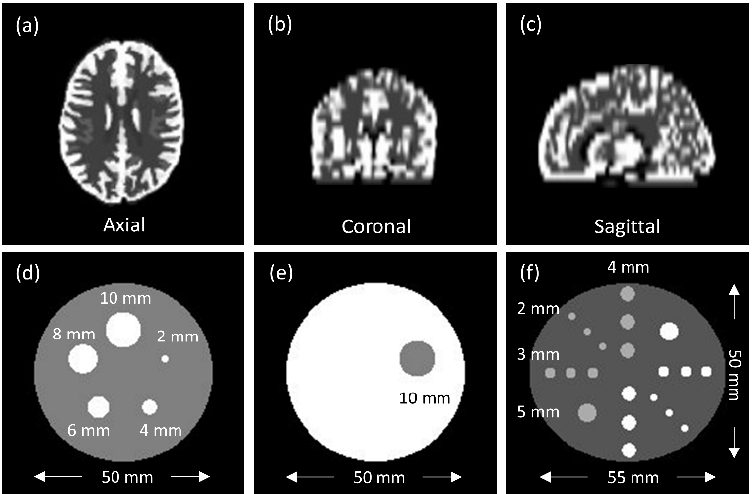
Figure 1. PHAN brain in ( a ) axial plane, ( b ) coronal plane, ( c ) sagittal plane, and the central axial slice of ( d ) PHAN 5rod , ( e ) PHAN 1sphere , ( f ) PHAN 20rod .